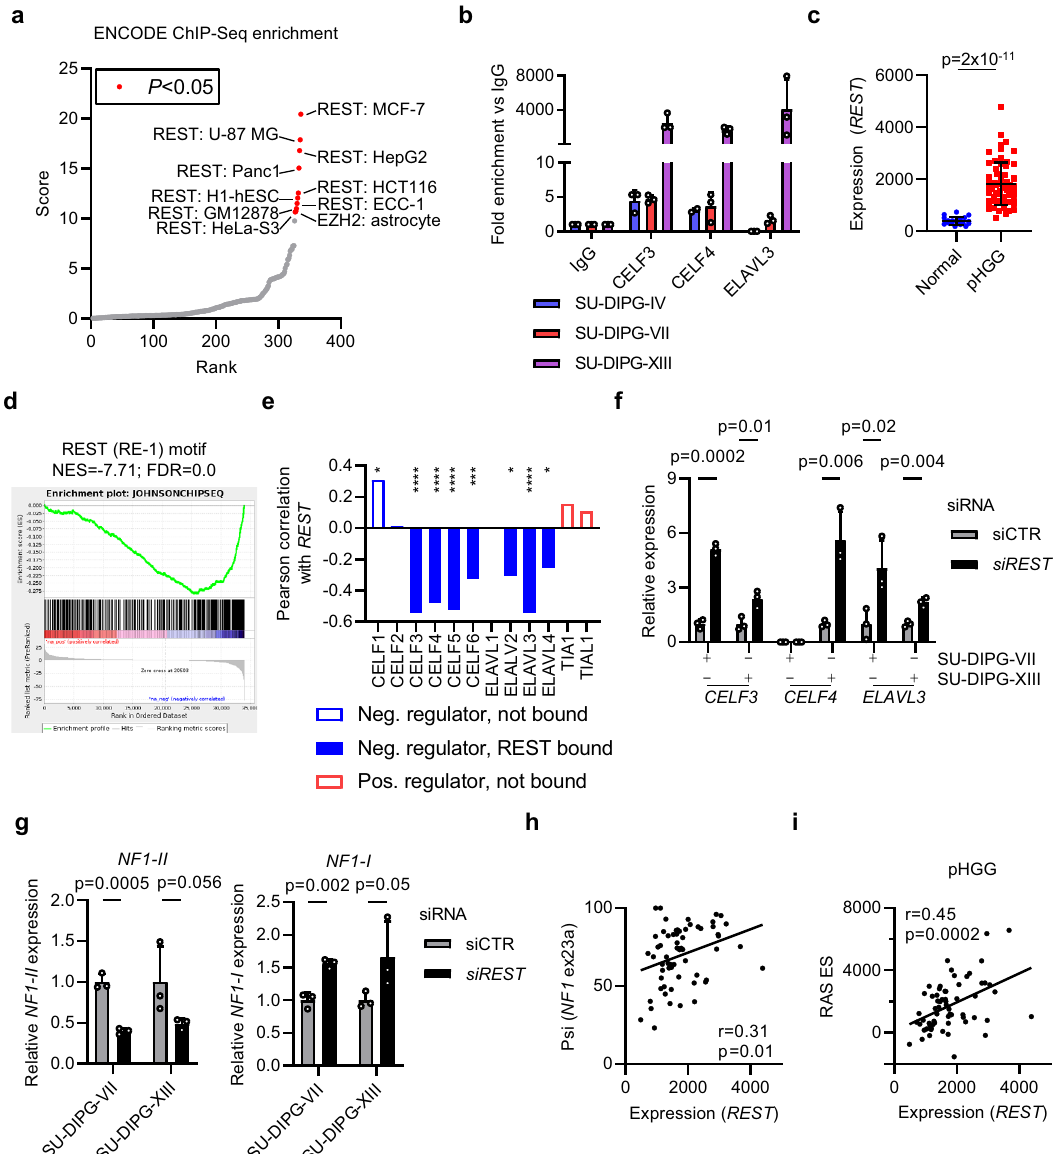
Fig. 7 NF1 exon23a splicing in pHGG is regulated downstream from REST. a Enrichment of transcription factor binding sites in NF1 exon23a splice regulators were calculated by Enrichr using ENCODE ChIP-Seq data. All signi fi cant results (FDR < 0.05, red) are highlighted red and the dataset labeled. b ChIP was carried out using REST or IgG antibodies with chromatin from primary DIPG cell lines and analyzed as percent input at the indicated loci ( n = 3). Bars show mean ± standard deviation. c REST expression in pHGG ( n = 64) and normal brain ( n = 20). Bars show mean ± standard deviation. d Gene set enrichment analysis of REST signature genes with a REST-bound RE1 motif. NES normalized enrichment score, FDR false discovery rate. e Pearson correlation of REST expression and expression of NF1 exon23a splice regulators (CELF1, P = 0.01; CELF3; P = 10 − 5 , CELF4, P = 10 − 4 , CELF5, P = 10 − 6 , CELF6, P = 0.01; ELAVL2, P = 0.01; ELAVL3, P = 10 − 5 , ELAVL4, P = 0.04). Genes bound by REST across ENCODE ChIP-Seq datasets are shaded in solid color, genes not bound by REST are empty. f qRT-PCR in SU-DIPG-VII and SU-DIPG-XIII cell lines transfected with control or REST -speci fi c siRNA. Bars show mean ± standard deviation ( n = 3) relative to 18S housekeeping, normalized to siCTR expression for each gene. g qRT-PCR in SU-DIPG-VII and SU- DIPG-XIII cell lines transfected with control or REST -speci fi c siRNA. Bars show mean ± standard deviation ( n = 3) relative to 18S housekeeping, normalized to siCTR expression for each gene. h Scatter plot of REST expression and NF1 exon23a inclusion in pHGG. r: Pearson correlation. i Scatter plot of REST expression and RAS pathway activity (ssGSEA ES) in pHGG. r: Pearson correlation. Statistical tests: t (all; multiple t tests with two-stage linear step-up procedure of Benjamini, Krieger, and Yekutieli ( f , g )). * P < 0.05, ** P < 0.01, *** P < 0.001, **** P < 0.0001. Source data are provided as a Source Data fi